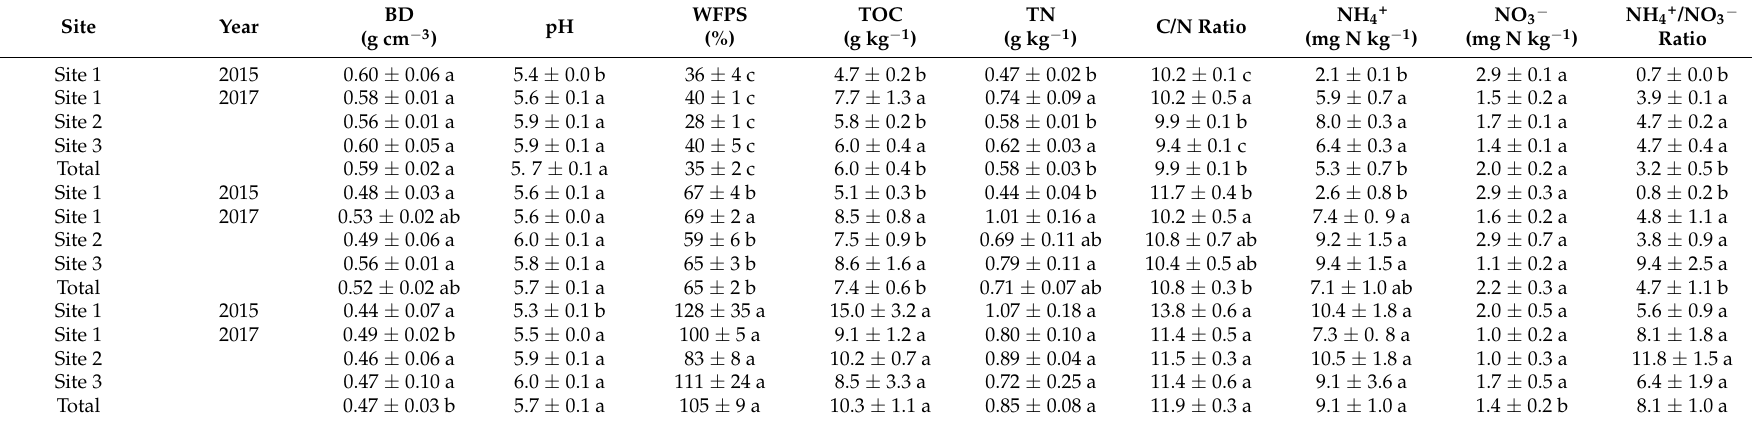
Data are presented as mean and standard errors. Values from different sites (1, 2, 3) and overall averages are shown. Different lowercase letters indicate significant differences among slopes ( p <